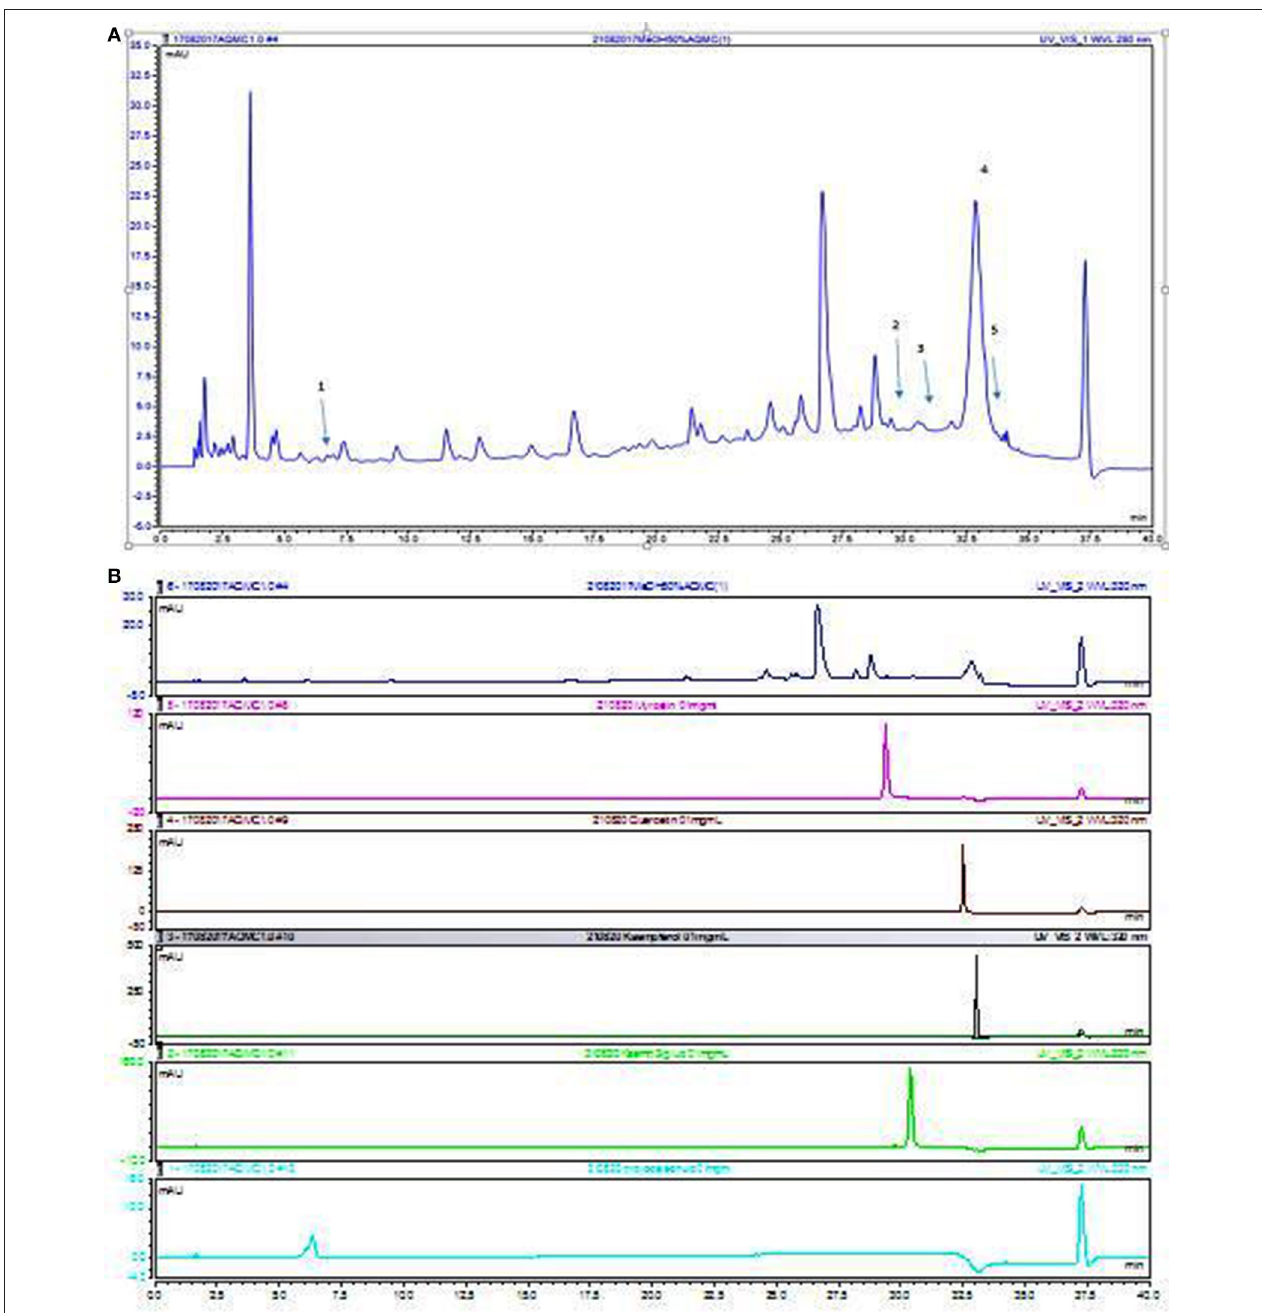
FIGURE 3 | UHPLC-UV of AQMC at 280nm. (A) The numbering of the peaks correspond to those reference standards shown in (B) 1. protocatechuic acid, 2.myricetin, 3. kaempferol-3- O- glucoside, 4. quercetin and 5. Kaempferol.